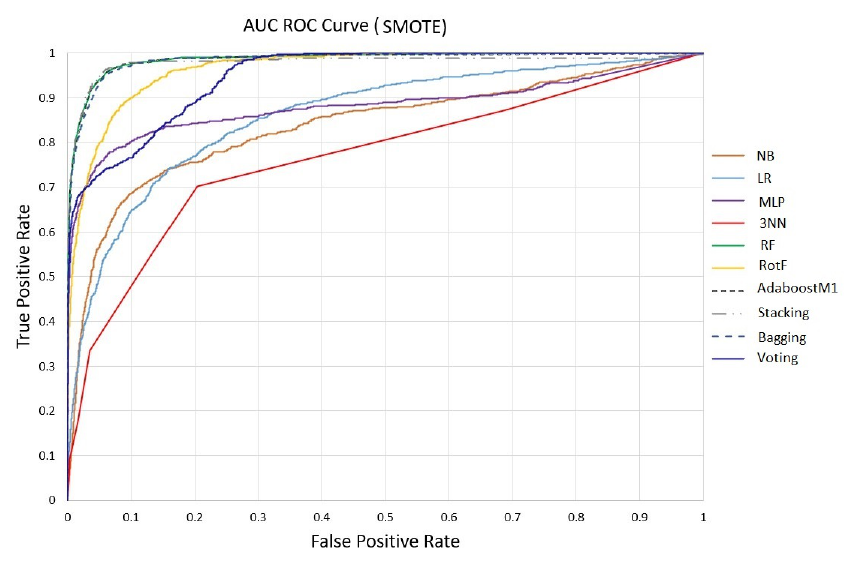
Figure 4. ML models AUC ROC Curve without SMOTE.